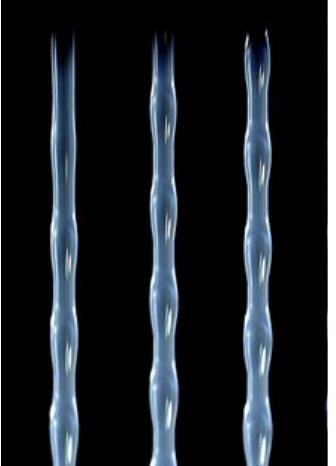
Figure 33. Formation of the bead-on-string structure — initial stage.